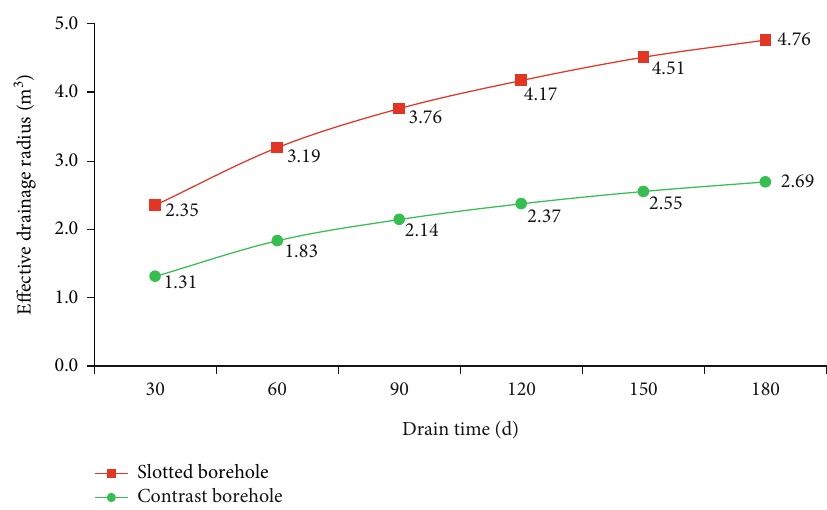
Figure 25: Change curve of e ff ective radius of kerf drilling and comparative drilling.